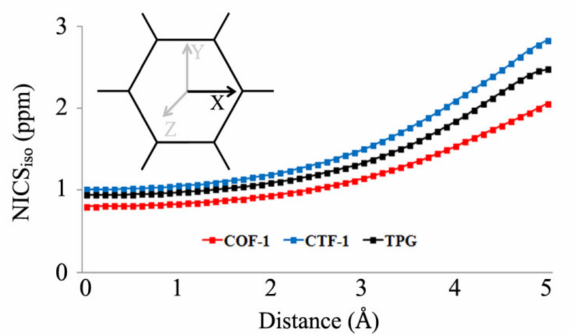
Figure 3. The curves of NICS iso scan calculated with 0.1 Å spacing along x